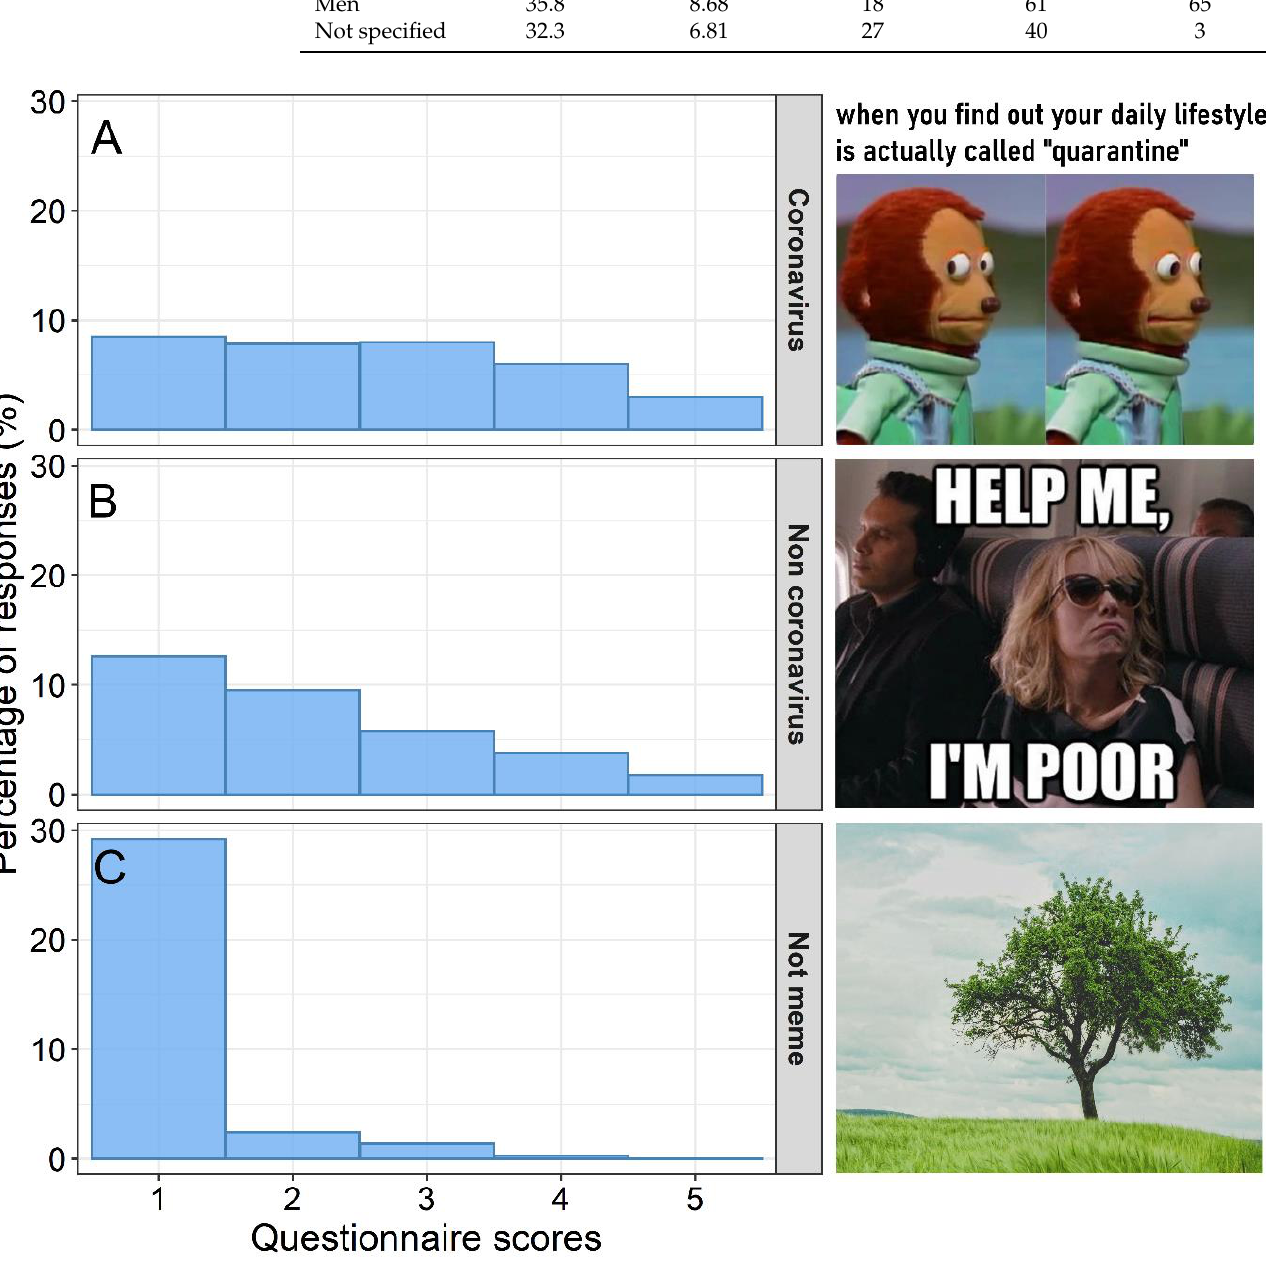
Figure 6. Histograms of funniness scores and exemplary memes and non-memes used in the ques- tionnaire. Frequency distribution (%) of different funniness scores ( x -axis) for ( A ) coronavirus memes, ( B ) non-coronavirus memes, and ( C ) images not memes (added to check if memes differ from ordinary images). Scores were on the ordinal scale: 1 = not funny at all, 2 = somewhat funny, 3 = funny, 4 = very funny, and 5 = extremely funny.